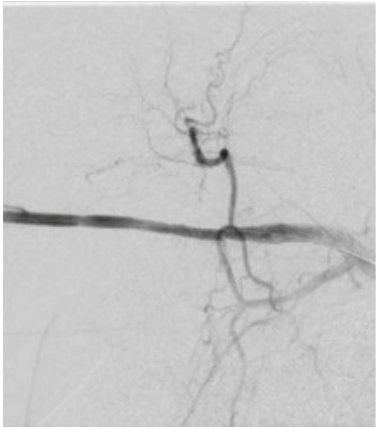
Figure 5: Repeat angiogram of the right brachial artery showed no residual stenosis after balloon angioplasty and stenting.